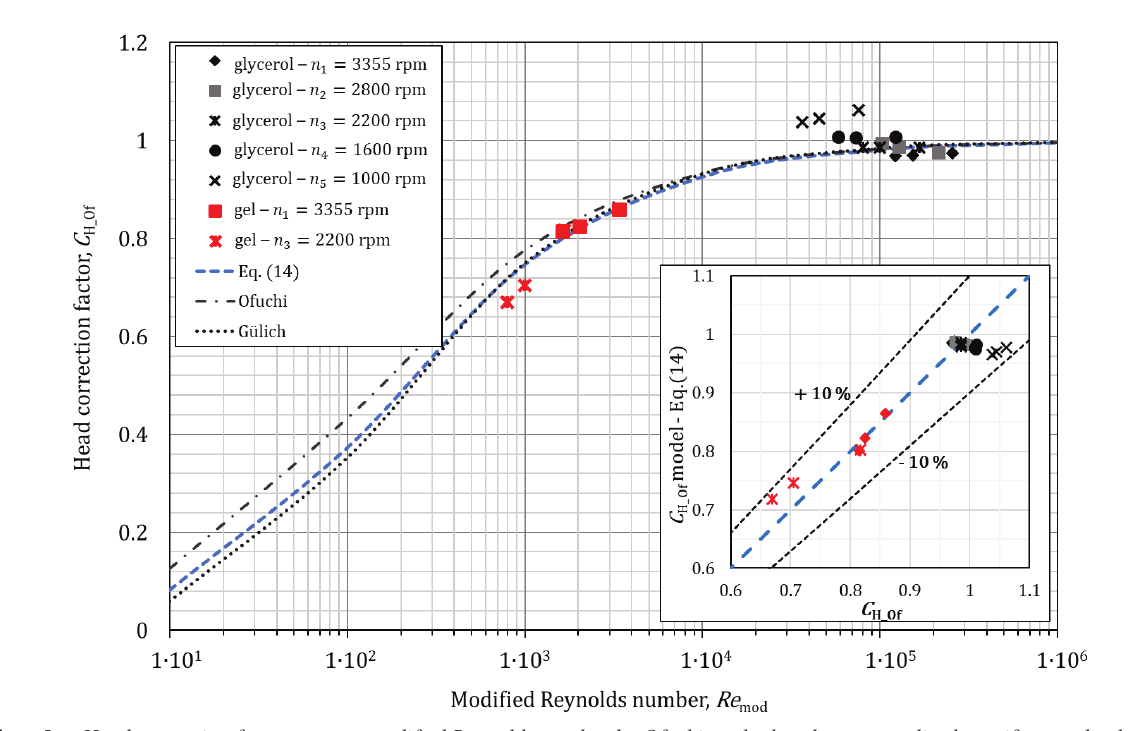
Fig. 5 – Head correction factors versus modified Reynolds number by Ofuchi method at three normalised specific speed values with Wilo-Helix-EXCEL 1602-1/16/E/KS pump. Blue dashed curve: actual fit, black dash-dotted curve: Ofuchi’s fit, dark grey dotted curve: Gülich’s